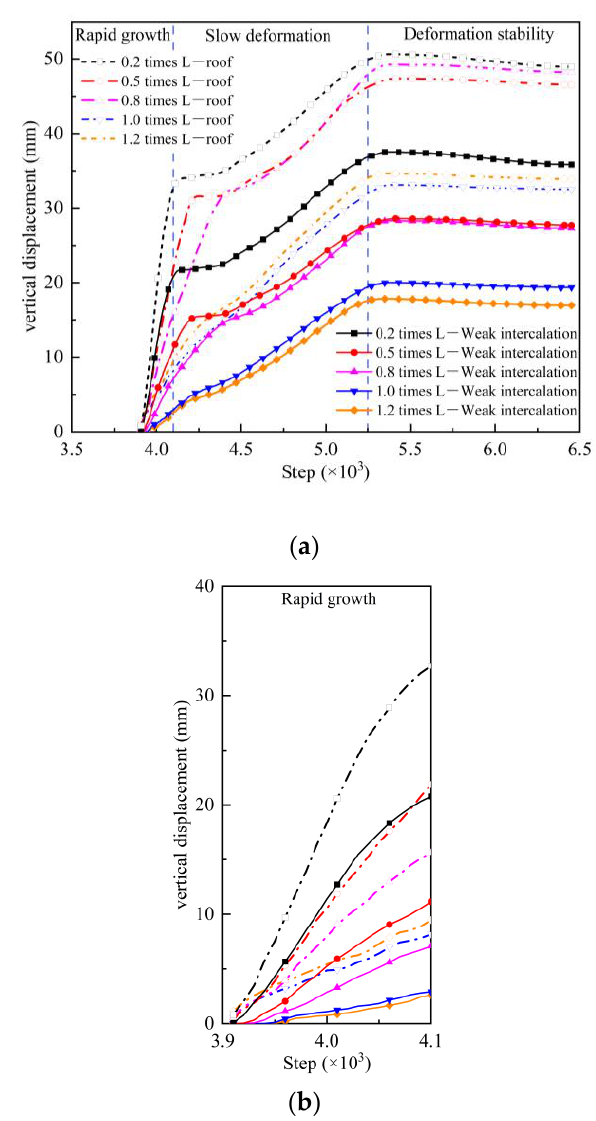
Figure 6. Vertical Displacement of Roadway Roof and Soft Rock Roof at Different Locations of Soft Rock Strata. ( a ) Displacement of roof and weak interlayer. ( b ) Enlarged view of the rapid development stage .